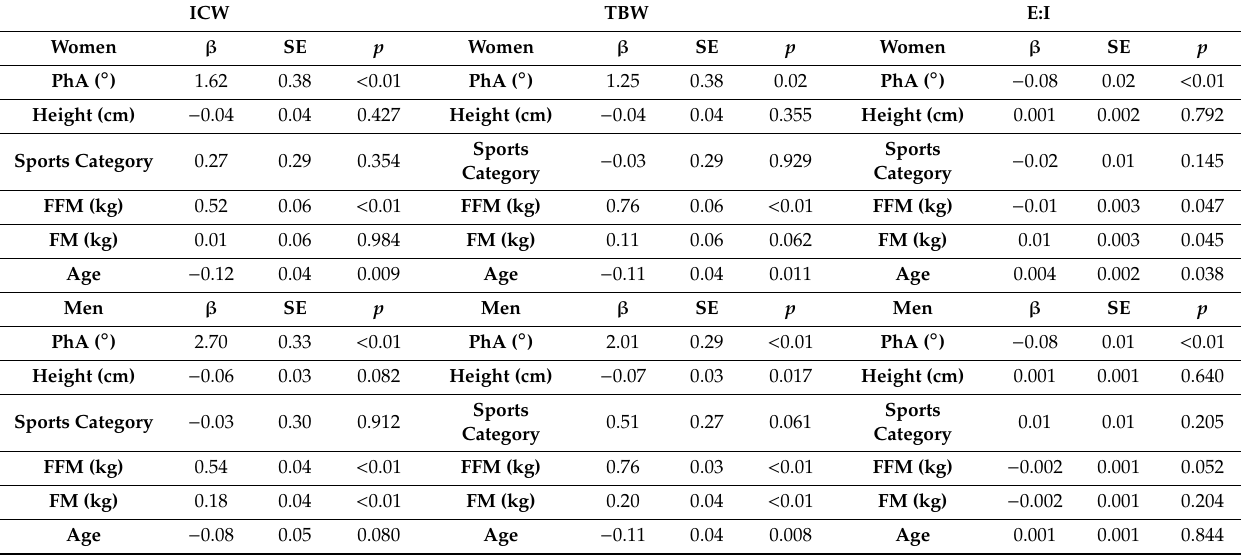
Table 3. Linear and Multiple Regression Analysis Between PhA and ICW, TBW and